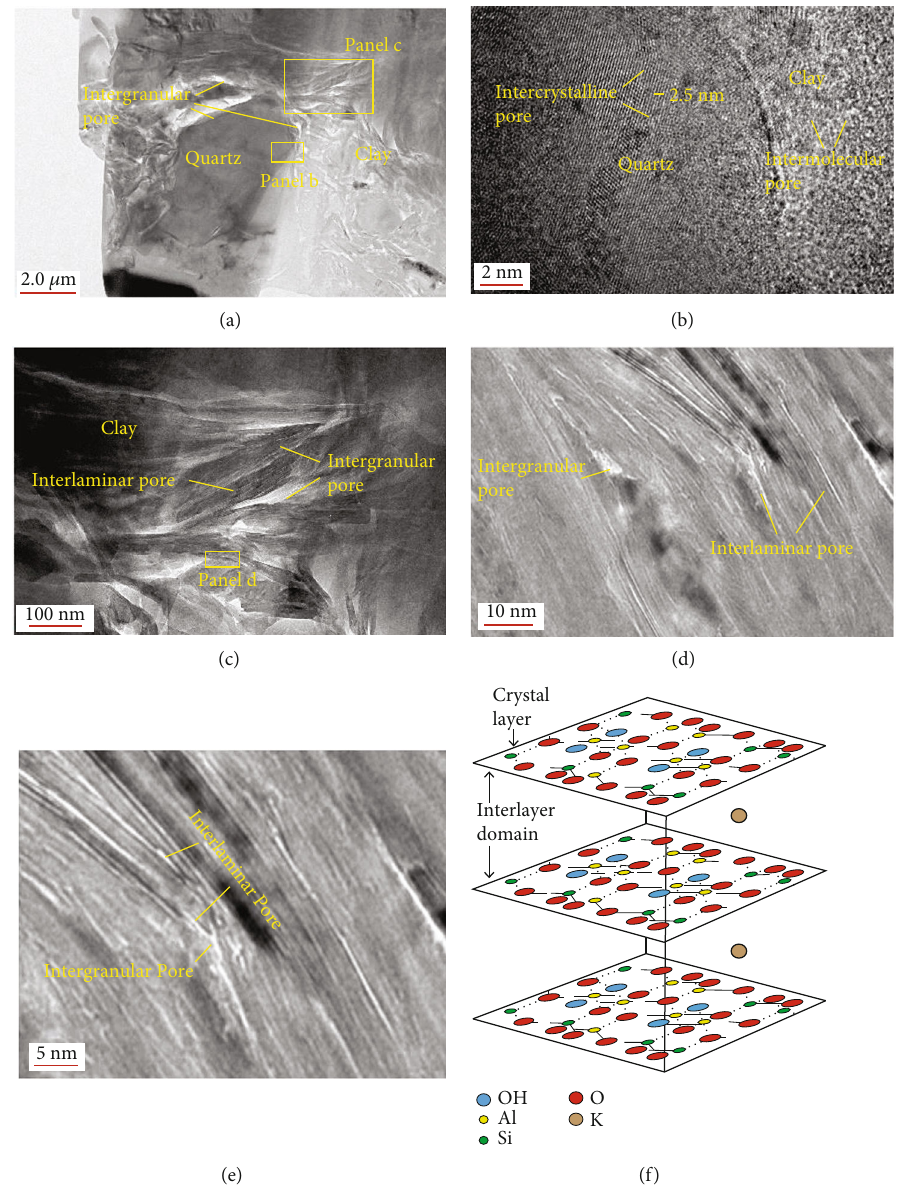
Figure 2: Microscopic pore characteristics. (a) Distribution characteristics of the intergranular pores. (b) Characteristics of the lattice quartz particles and intermolecular pores of the clay minerals. (c) Characteristics of intergranular pores, interlaminar pores. (d) Deformational characteristics of the clay mineral lamellar crystals and interlaminar pores. (e) Two ends of the interlaminar pores (slits) were connected to the interparticle pores. (f) Diagram of the layered structure of illite. Note: white areas shown in the TEM images are the